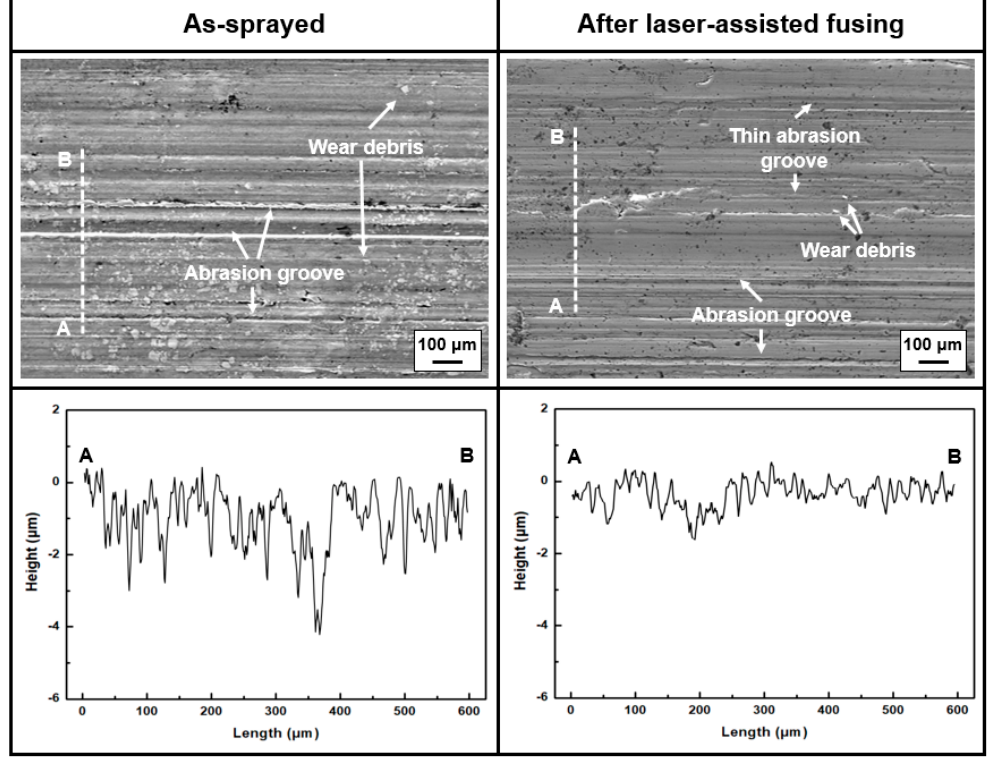
Figure 12. Surface morphology and line profile of worn surface of as-sprayed 1276F coating and that after laser-assisted fusing at 1473 K.